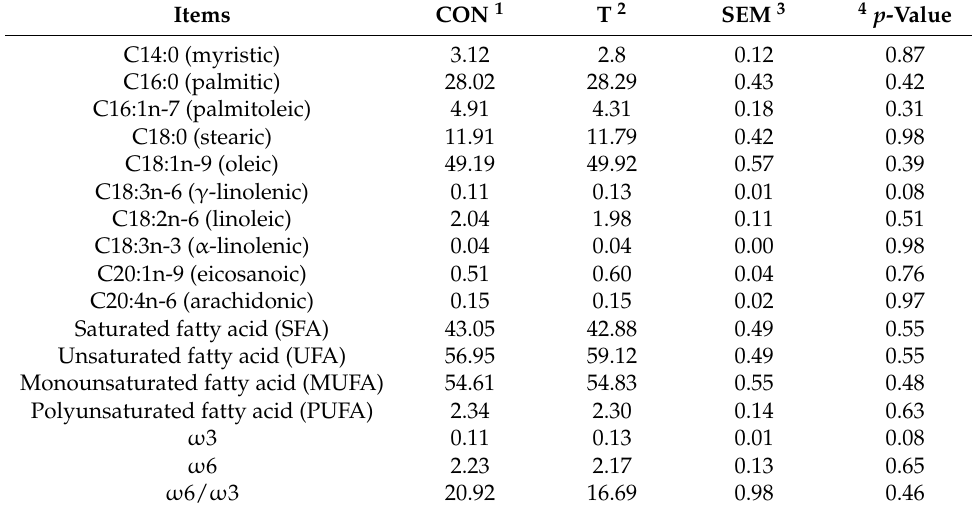
Table 6. Fatty acid compositions in Hanwoo steers fed with control or formulated